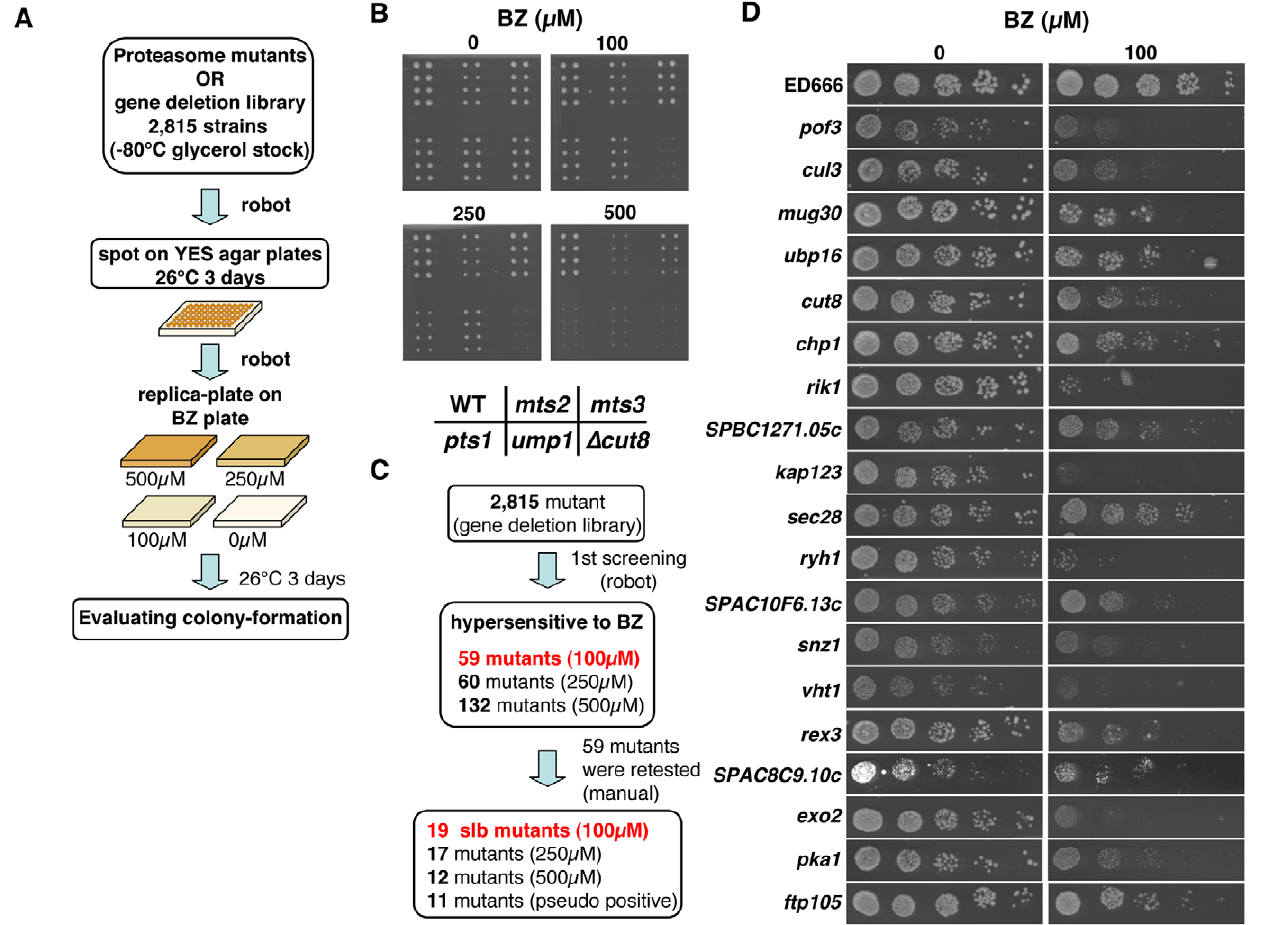
Figure 2. Synthetic lethal screening with Bortezomib. ( A ) Strategy for synthetic lethal screening ( B ) Mutants of components of the ubiquitin/ proteasome pathway are hypersensitive to Bortezomib. Eight colonies of each strain were replica-plated onto agar plates with various concentrations of Bortezomib and were incubated for 3 days at 26 u C. ( C ) Summary of synthetic lethal screening with Bortezomib. See text for details. ( D ) Validation of isolated mutants that had growth defects in 100 m M Bortezomib by spotting 5-fold serial dilutions of vegetative growing cells.